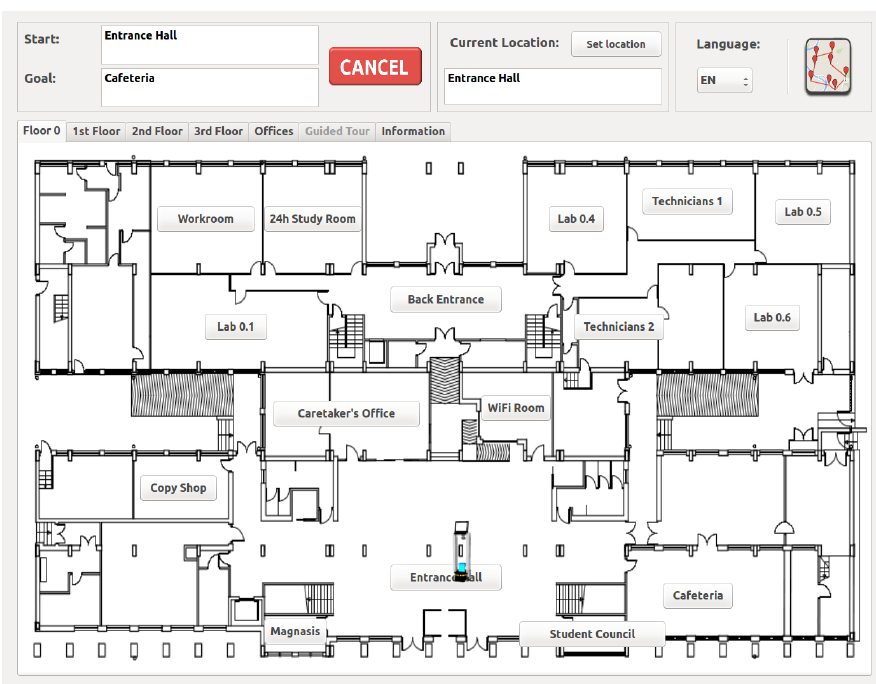
Figure 2. Main view of the GUI. The visible tab corresponds to the ground floor where a PeopleBot robot is present at the main entrance waiting for the visitors (reproduced with permission from Springer Nature under License Number